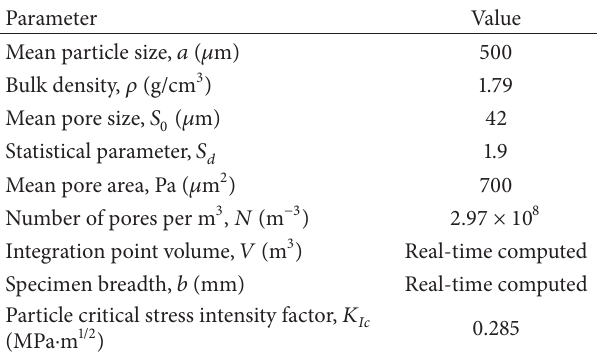
Table 3: Burchell parameters of H-451 graphite.